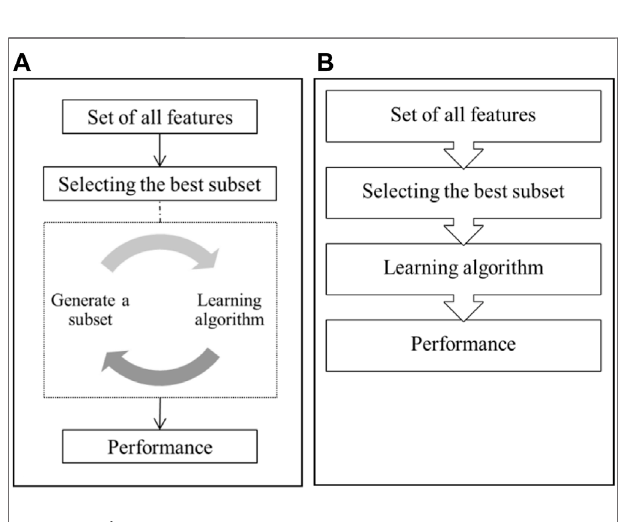
FIGURE 2 | Schematic of wrapper (A) and fi lter algorithms (B) . FIGURE 3 | Schematic of extreme learning machine